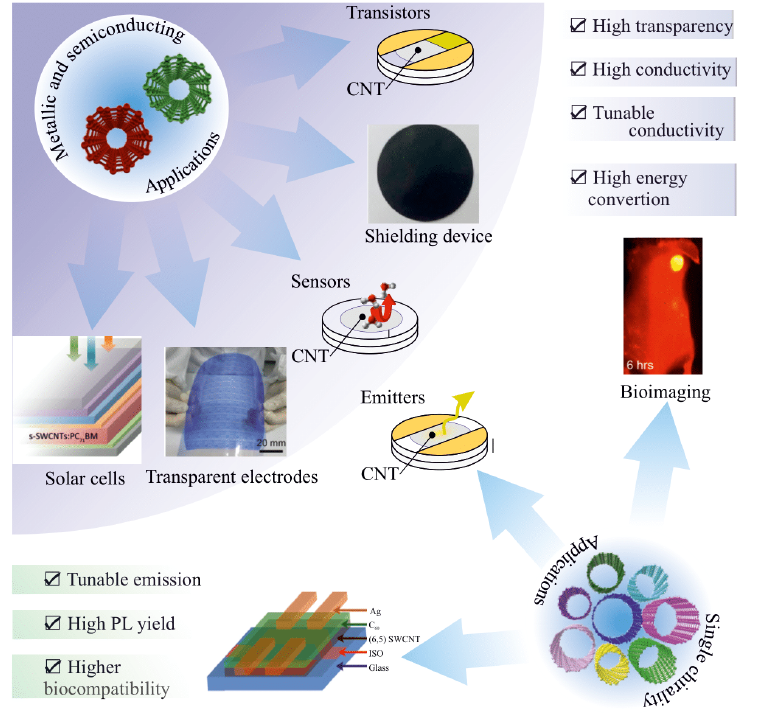
Figure 19. Overview of sorted SWCNT applications and benefits of using these materials. Sorted pure semiconducting and metallic SWCNTs can be used as a part of transistors, shielding devices, sensors, transparent electrodes, and solar cells. Meanwhile, chirality-enriched SWCNTs can be used for bioimaging, emitters, and solar cells.